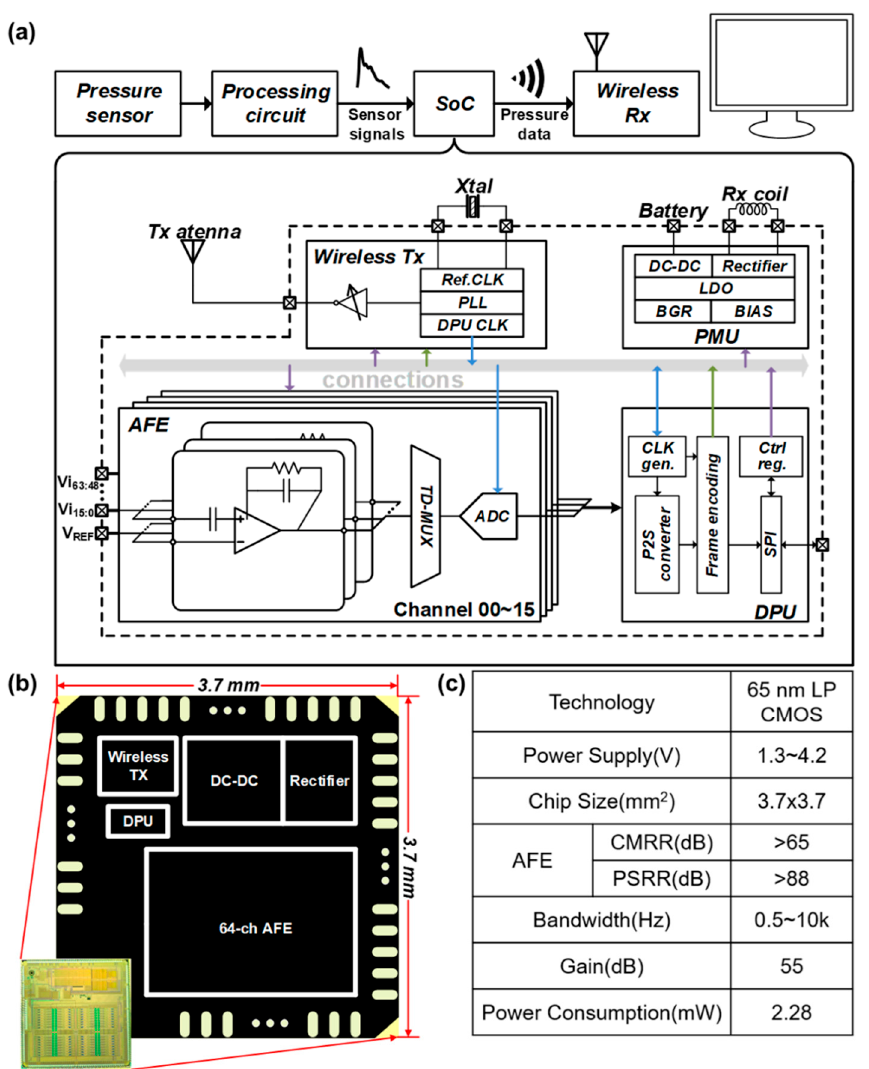
cations of the chip.